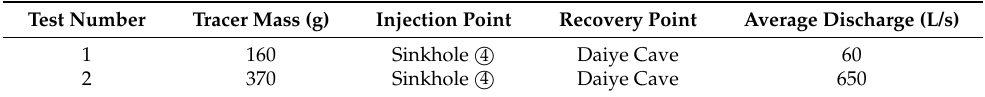
Table 1. Information of tracer tests in Daiye